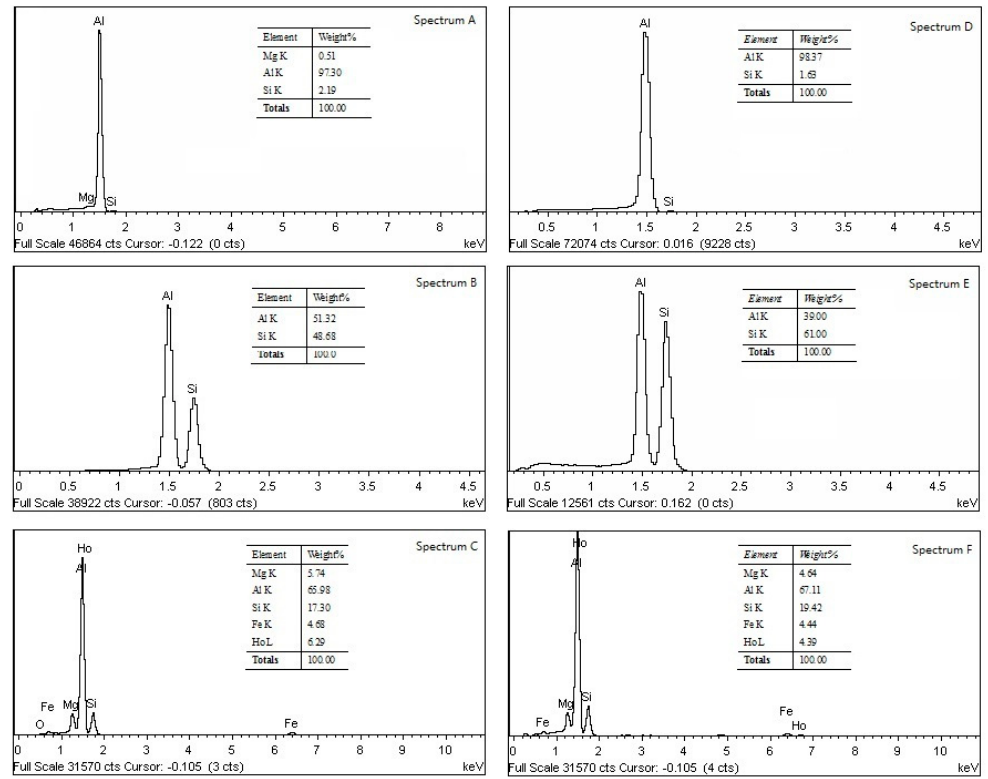
Figure 6. Elements in phases of the Ho-modified alloys by EDS.